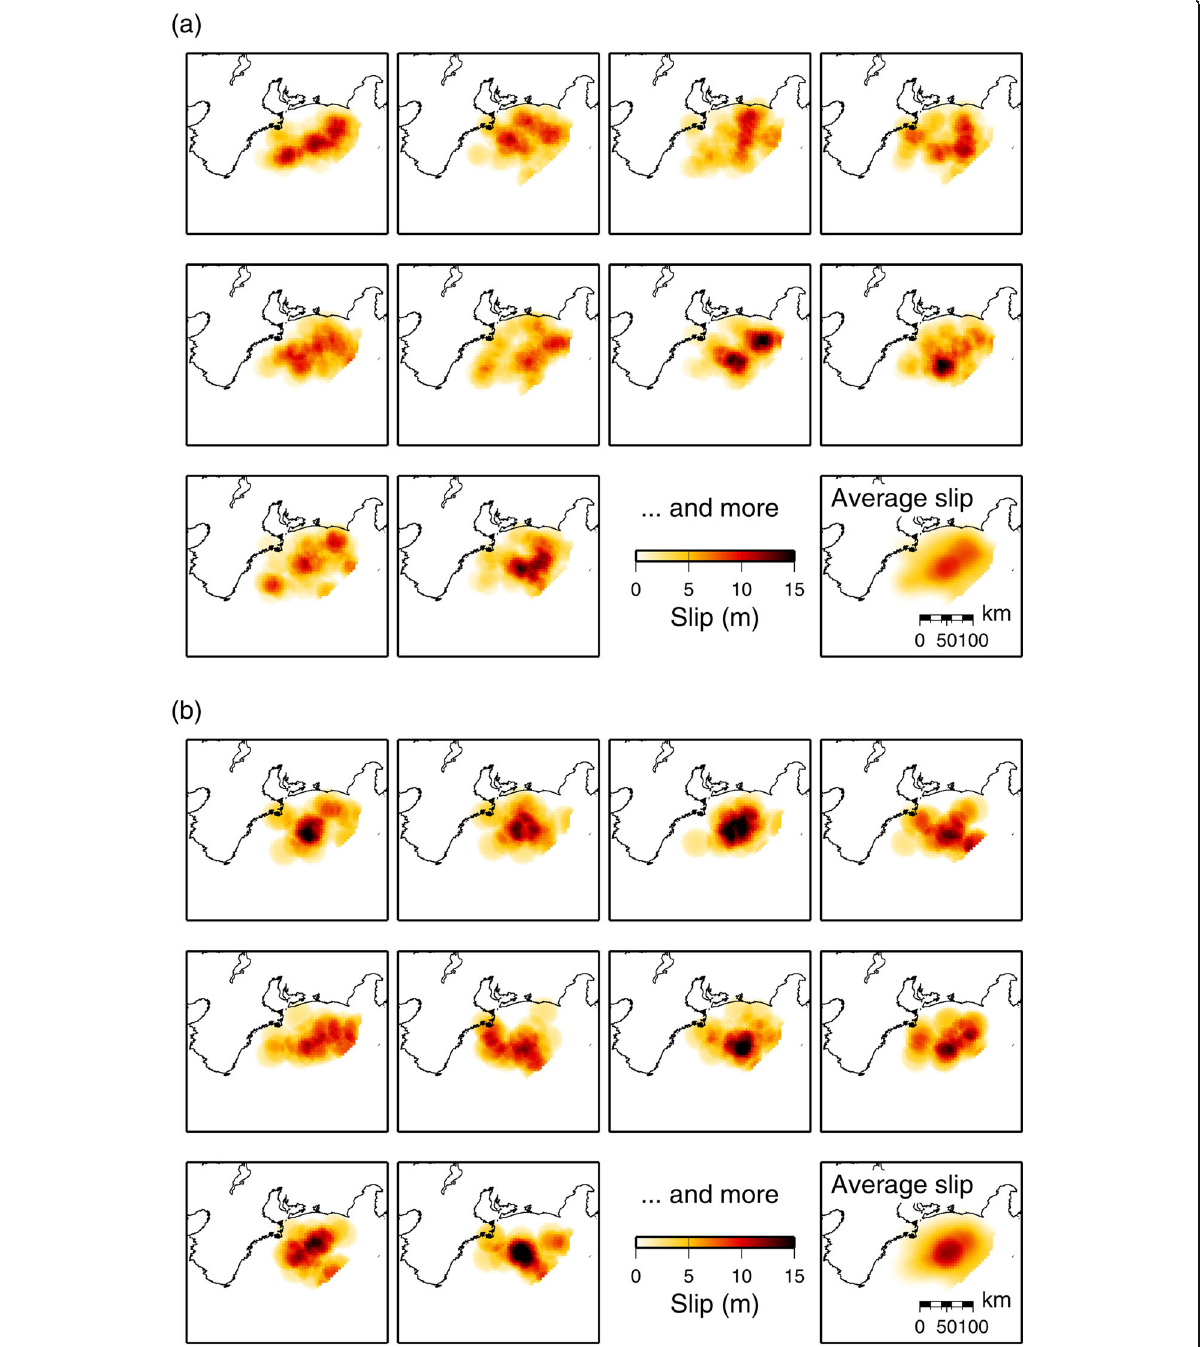
Fig. 2 Examples of individual slip distributions and average slip distributions. Two sets each of 100 scenario M w 8.2 earthquakes were generated using a parameters R max = 0.2 and n a = 60 and b parameters R max = 0.25 and n a =